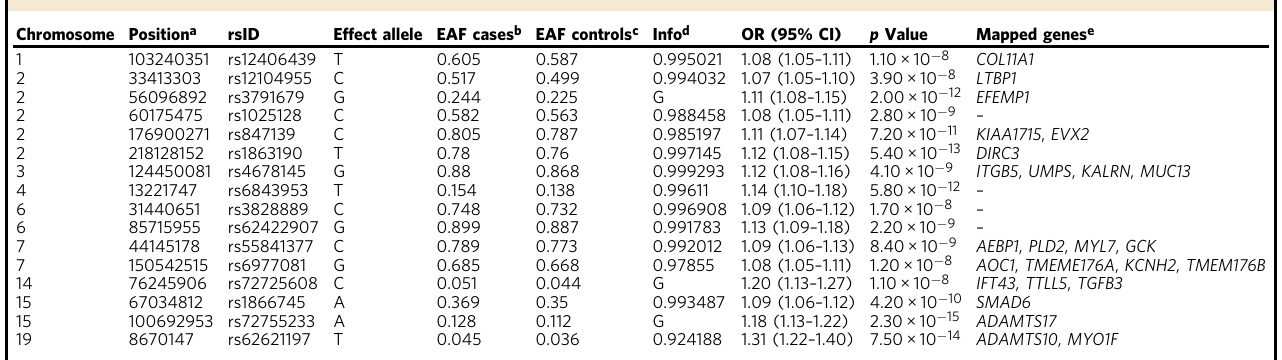
Table 1 SNPs signi fi cantly associated with carpal tunnel syndrome